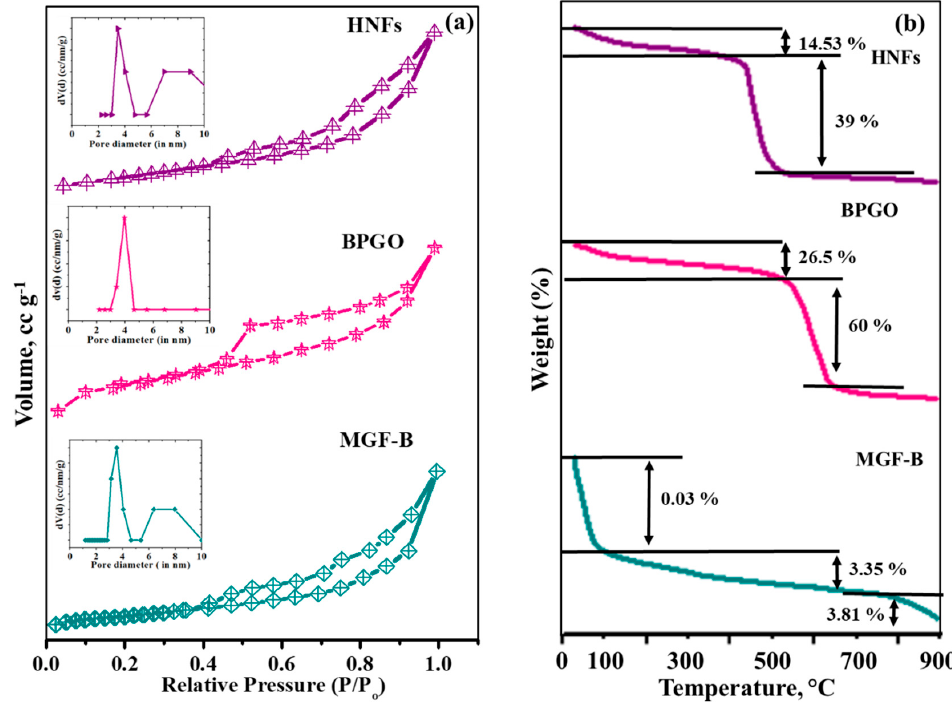
Figure 5. ( a ) BET isotherms, pore size distribution (inset) and ( b ) TGA plots of MGF − B, BPGO and HNFs.